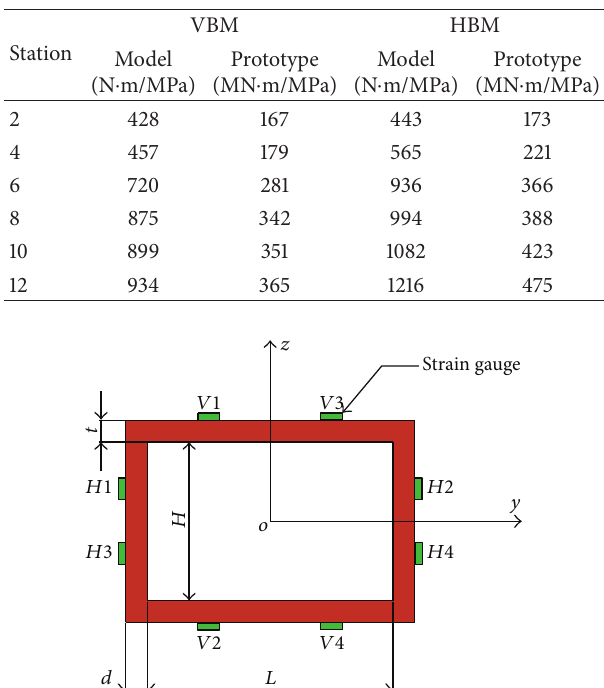
Table 2: Conversion coefficients.